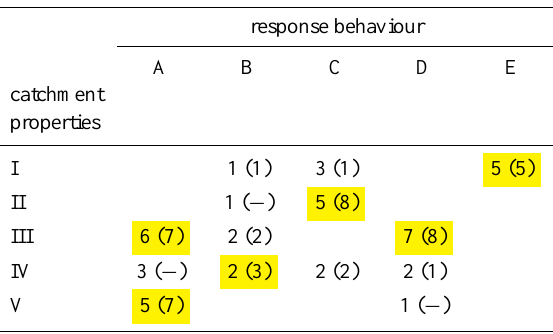
Table 3. Overlap between clusters of response behaviour (A to E) and clusters of catchment properties (I to V). Numbers indicate the number of corresponding catchments. Numbers in brackets indi- cate the number of corresponding catchments considering border- line catchments assigned to their second best cluster. Correspond- ing clusters are marked in